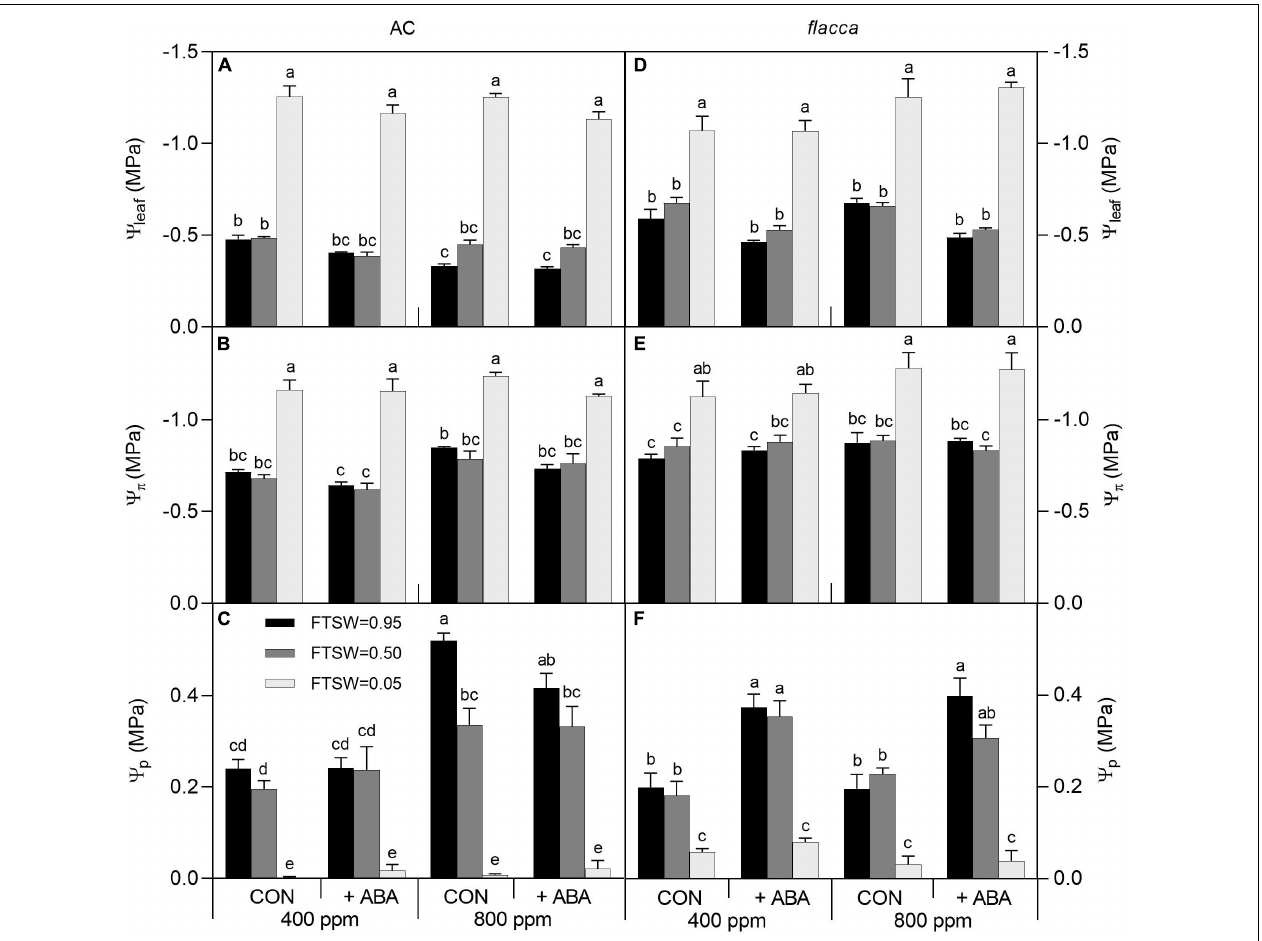
FIGURE 4 | Leaf water potential ( (cid:57) leaf ), osmotic potential ( (cid:57) π ), and turgor pressure ( (cid:57) p ) in AC (A–C) and flacca (D–F) grown under ambient (400 ppm) and elevated (800 ppm) CO 2 concentrations during progressive soil drying. CON indicates the control treatment sprayed with water, +ABA indicates exogenous ABA application. FTSW indicates the fraction of transpirable soil water. Different letters on the top of the columns indicate a significant difference between the treatments by Tukey’s test at p < 0.05. Error bars indicate the standard error of the means (S.E.) ( N =